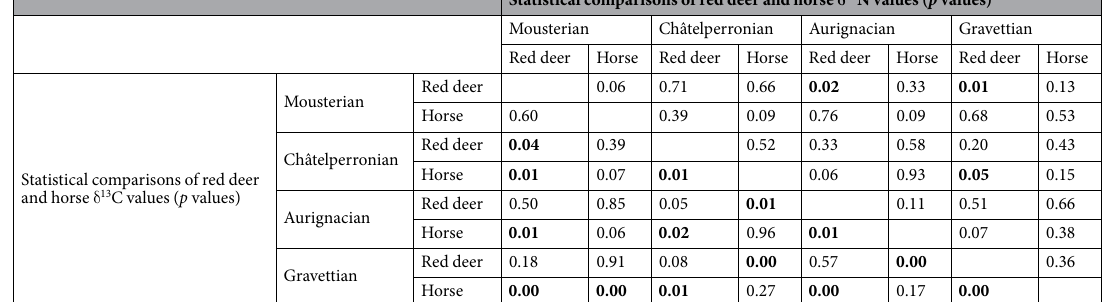
Statistical comparisons of red deer and horse δ 13 C values ( p values)